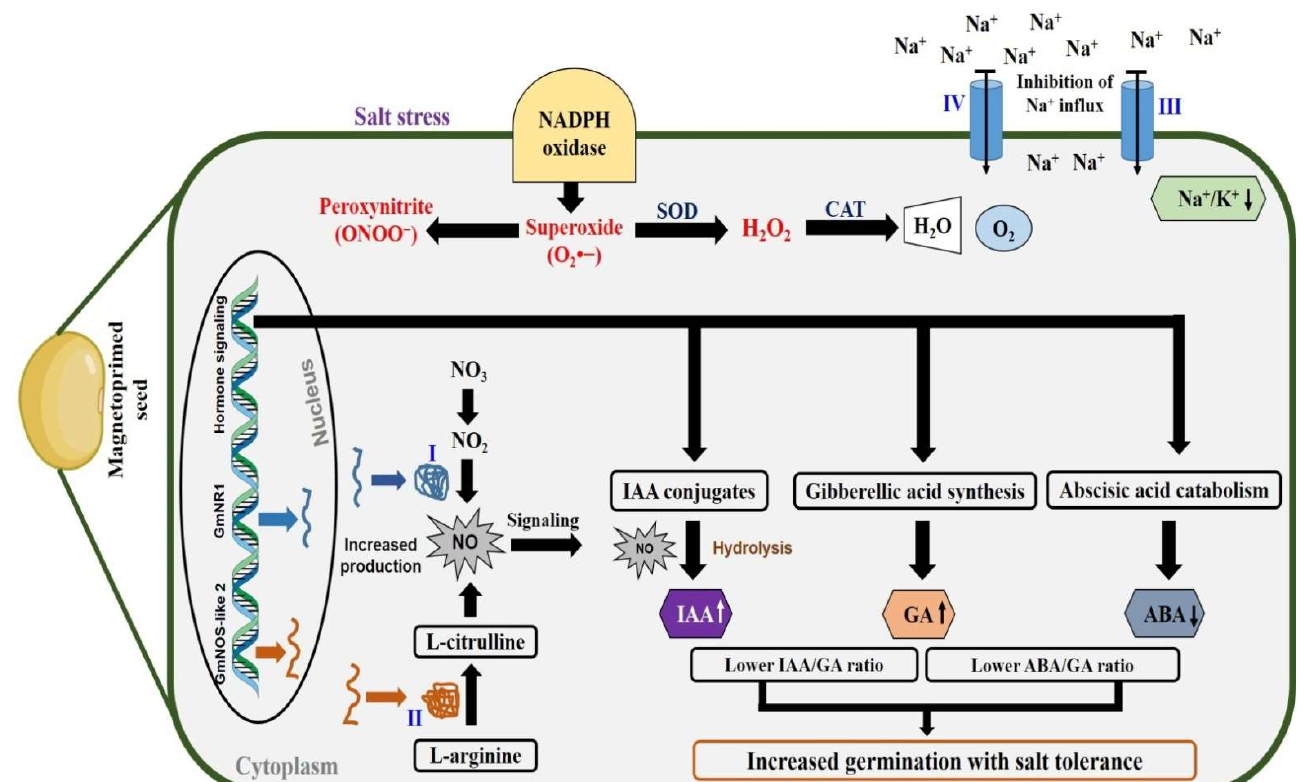
Figure 8. Proposed model for magnetopriming-induced salt tolerance in soybean seeds. Magnetopriming of soybean seeds promotes NO synthesis via (I) Nitric oxide synthase-like and (II) Nitrate reductase. There may be involvement of (III) Plasma membrane H + -ATPase and (IV) Na + /H + antiporter. The Na + influx may be regulated by enzyme activities of plasma membrane III and IV. NO regulates homeostatic control of ABA/GA and IAA/GA ratio in magnetoprimed seeds. Overall, magnetopriming-induced NO-mediated homeostasis of germination hormones and lower Na + /K + ratio improve the salt tolerance index in soybean seeds. SOD = Super oxide dismutase, CAT = Catalase.